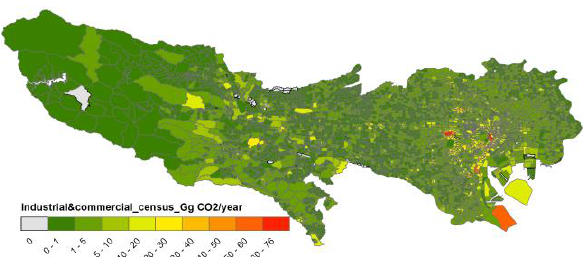
Figure 5. CO 2 emissions from industrial & commercial sector estimated from economic census, unit: Gg CO 2 yr -1